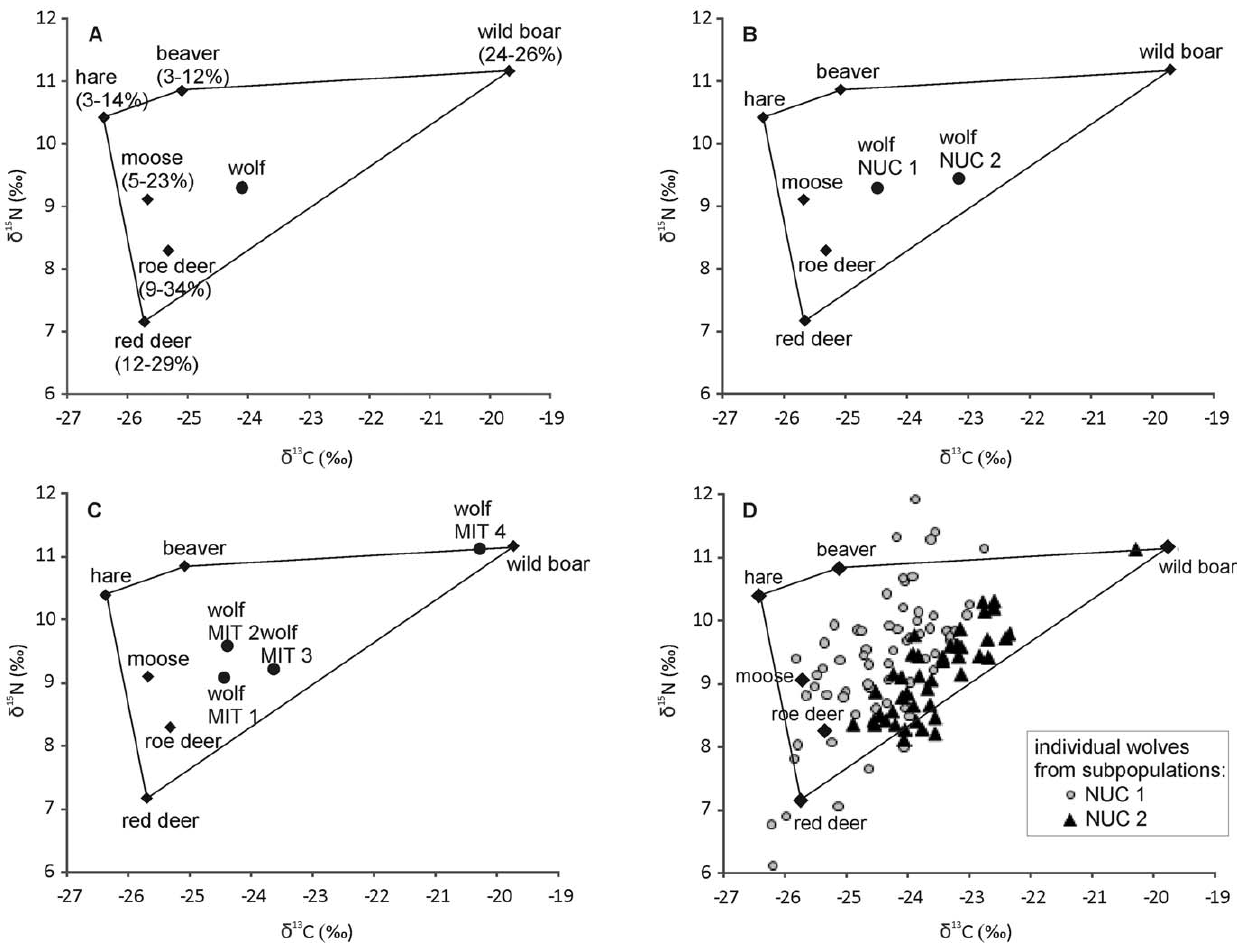
Figure 2. IsoSource dietary mixing polygon for Eastern European grey wolves. The wolf d 13 C and d 15 N values are plotted with potential prey. Trophic enrichment values of 1.3 % for d 13 C and 4.6 % for d 15 N [17] were added to the mean d 13 C and d 15 N values of potential prey. Stable isotope profiles are presented as mean and standard deviation for: (A) The entire wolf population. Contribution of each prey species to the diet is reported as the 25th to 75th percentile ranges of the estimated feasible distributions; (B) Subpopulations delimited based on microsatellite loci (NUC 1 and 2); (C) Subpopulations delimited based on mtDNA (MIT 1-4); (D) All analyzed individuals. Subpopulation MIT4 was represented by only one individual, and it was excluded from DISTLM analysis (see Materials and Methods). For standard deviation of prey stable isotope profiles, see Figure S2.